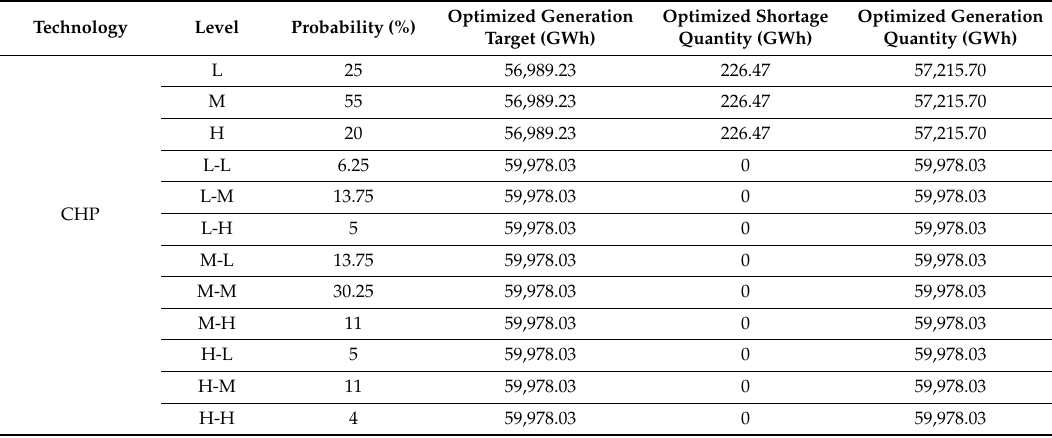
Table 4. The optimized power generation schemes under λ =